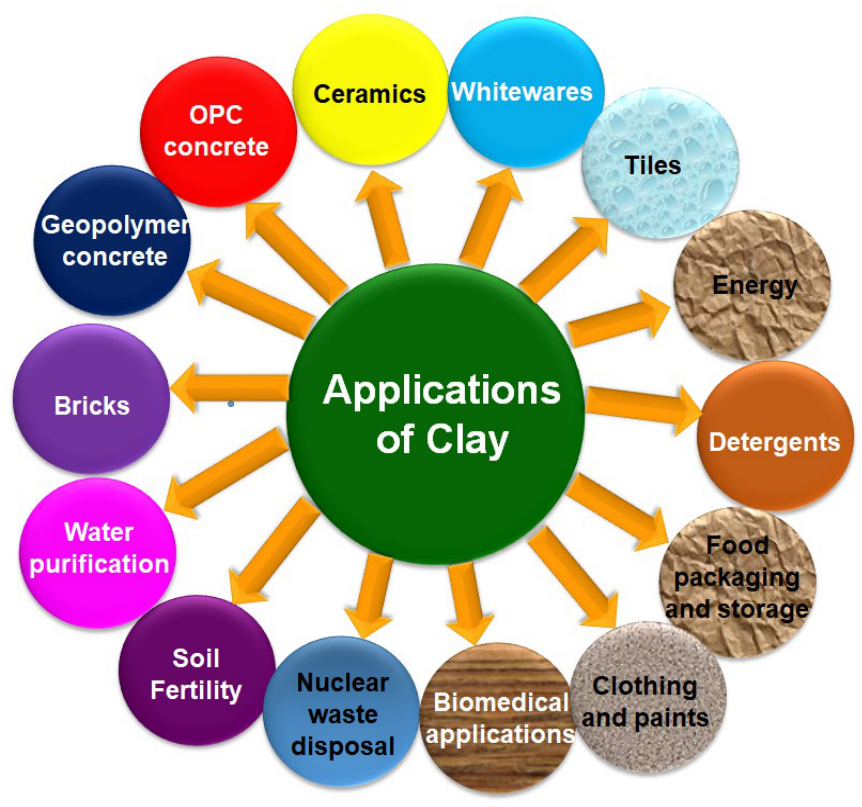
Figure 2. Applications of clay in different sectors.